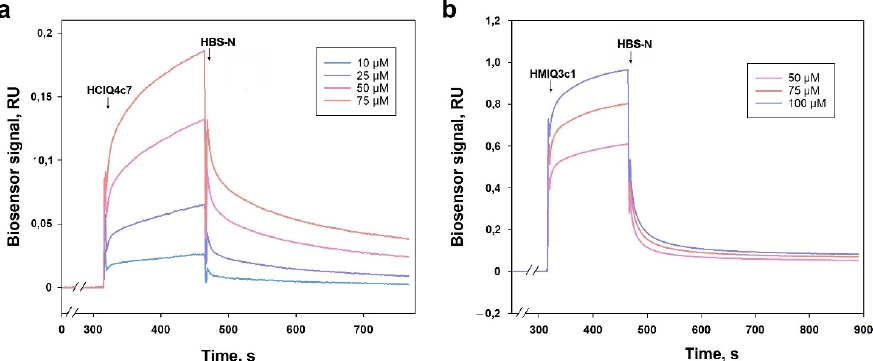
Figure 13. Binding sensorgrams of immobilized P2X7R with HCIQ4c7 ( a ) and HMIQ3c1 ( b ) at 25 °C. Correspondence of line colors to the peptide concentrations is shown in frame. The injection times of the peptides and HEPES-buffered saline (HBS-N) are shown by a black arrow.